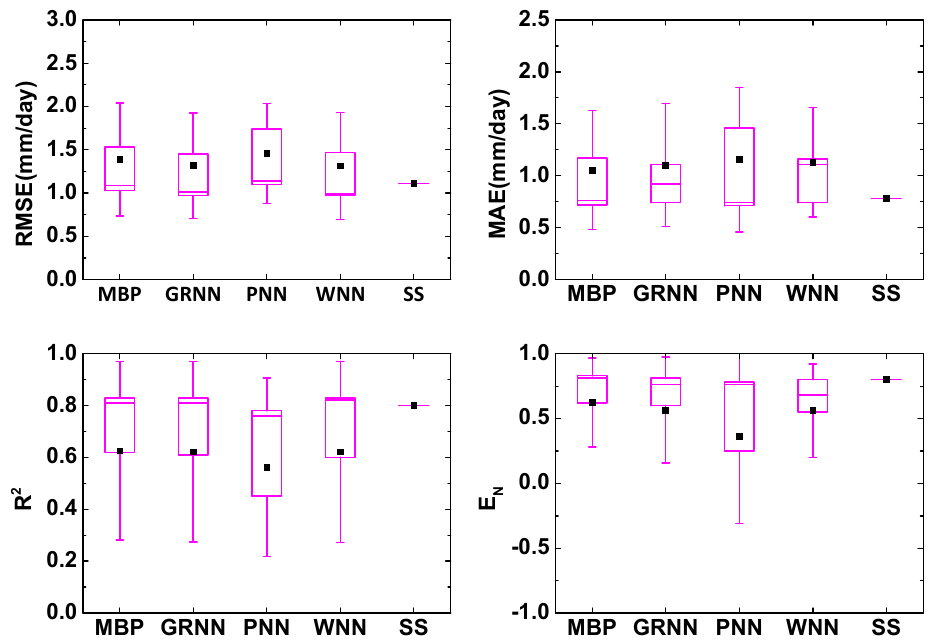
Figure 4. Statistics of different models at all stations.